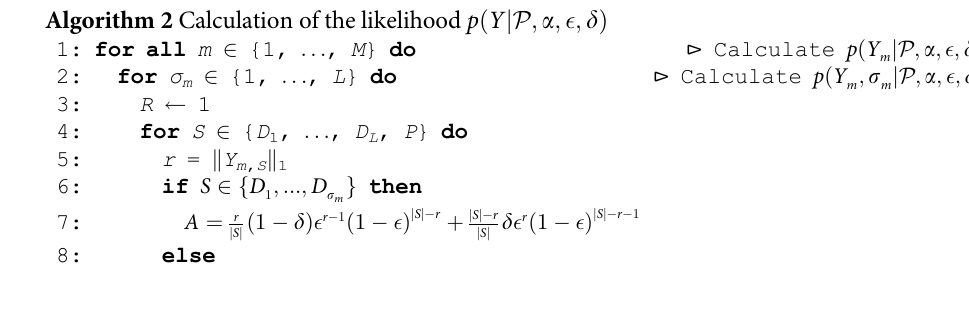
Algorithm 2 Calculation of the likelihood p ð Y j P ; a ; �; d Þ